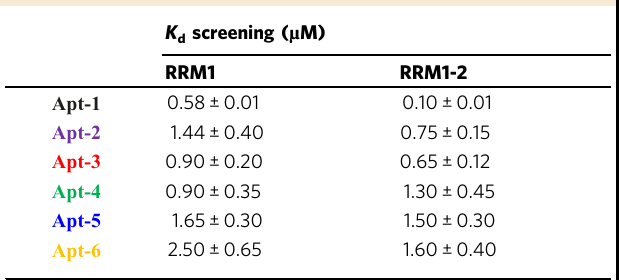
Table 1 Binding af fi nities of the RNA aptamers for RRM1 and RRM1-2.